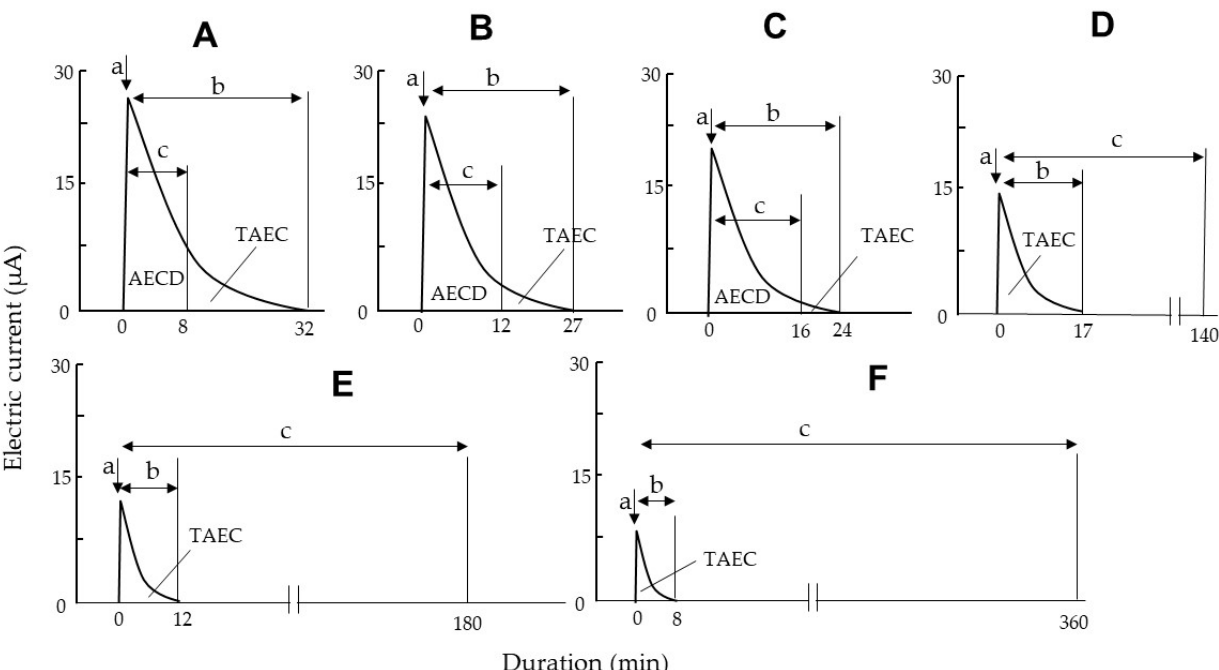
Figure 5. Typical profiles of electric current generated by an adult housefly placed on a grounded iron plate in a negatively charged insulated conductor (an insulated iron plate, NC-IP) with voltages of − 15 ( A ), − 14.5 ( B ), − 14 ( C ), − 12 ( D ), − 10 ( E ), and − 8 kV ( F ). Arrows ‘a’ and ‘b’ indicate the electric current produced by the fly upon attraction to the NC-IP and the subsequent electric current generated by the captured fly, respectively. The total amount of electricity released from the captured fly was determined as the total amount of electric current (TAEC; μ A min) generated by the fly, calculated as the area bounded by the x ‐ axis and the profile curve of current generation. Arrow ‘c’ indicates the time until death of the captured fly. The total amount of electric current (AECD) until fly death was also calculated [24].